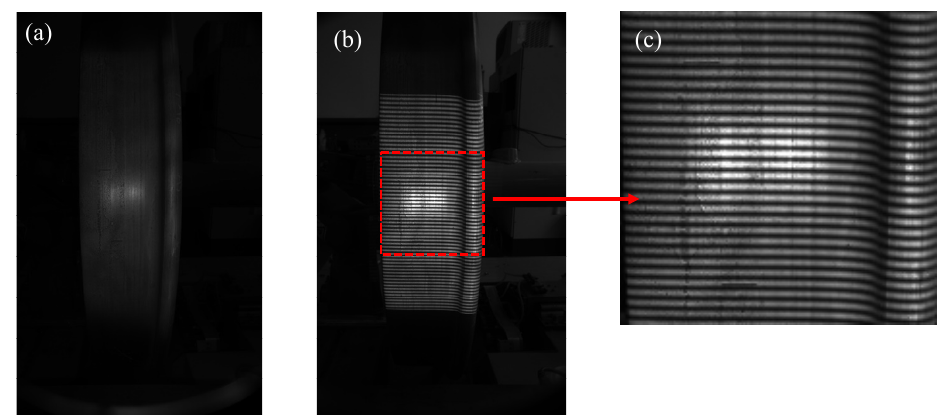
Figure 3. ( a ) The measured wheel-tread object; ( b ) deformed fringe; ( c ) enlarged details of the indicated region in ( b ).